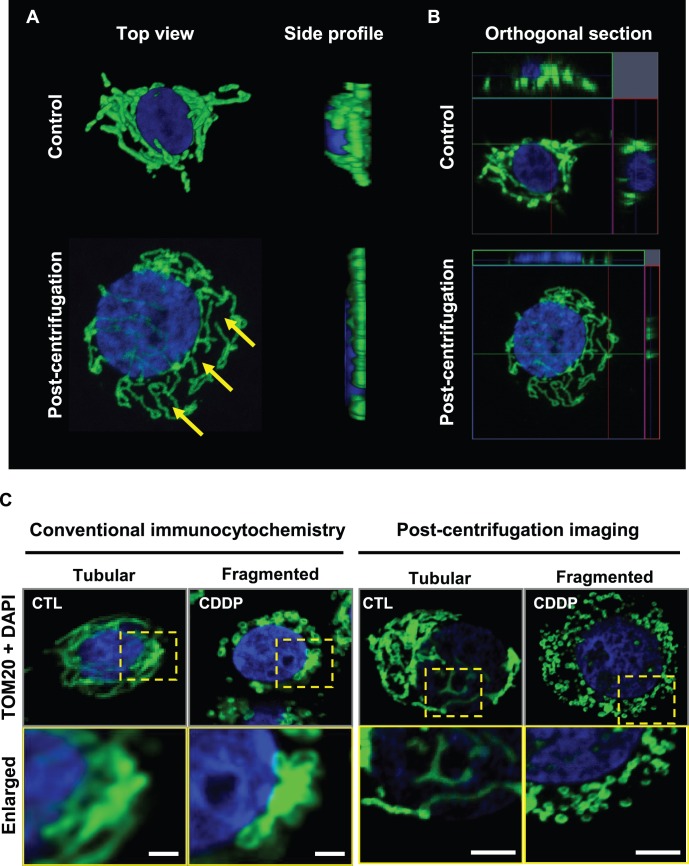
Effect of cytological centrifugation on mitochondrial imaging with confocal microscopy.(A) 3-dimensional top view and side profiles of untreated OV2008 cells, with and without cytological centrifugation prior to fixation. Yellow arrows indicate typical areas of separation that appear between mitochondria after centrifugation. (B) Orthogonal sections of the same images seen in (A) taken with identical camera exposure settings. Cells were fixed in 3.7% paraformaldehyde and stained for nuclear (DAPI, blue) and mitochondrial (TOM20, green) signal. (C) Comparison of mitochondrial image quality between conventional immunocytochemistry and cytological centrifugation approaches. Images of classical tubular and fragmented mitochondrial morphology becomes visibly sharper after centrifugation due to the minimization of fluorescence originating from background sources beyond the focal plane. The enlargement of the nucleus post-centrifugation is due to flattening of the cells by centripetal force. Scale bars = 5 µm.